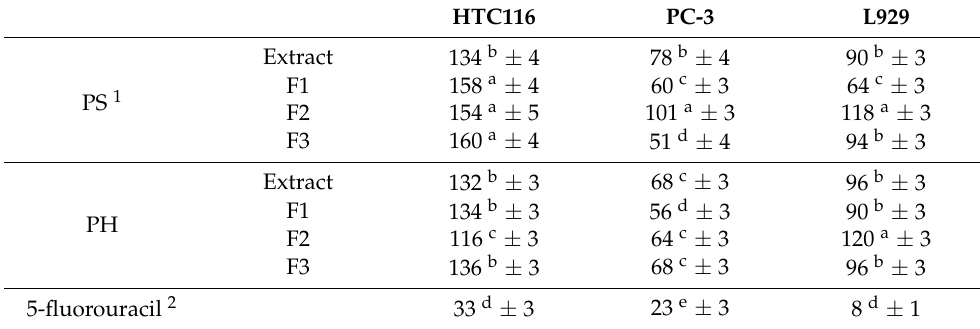
Table 2. Anticancer activity of ethanolic extract (E) and water (F1), methanol-water 40% (F2), and 70% (F3) fractions obtained from sweet (PS) and hot (PH) pepper fruit (IC 50